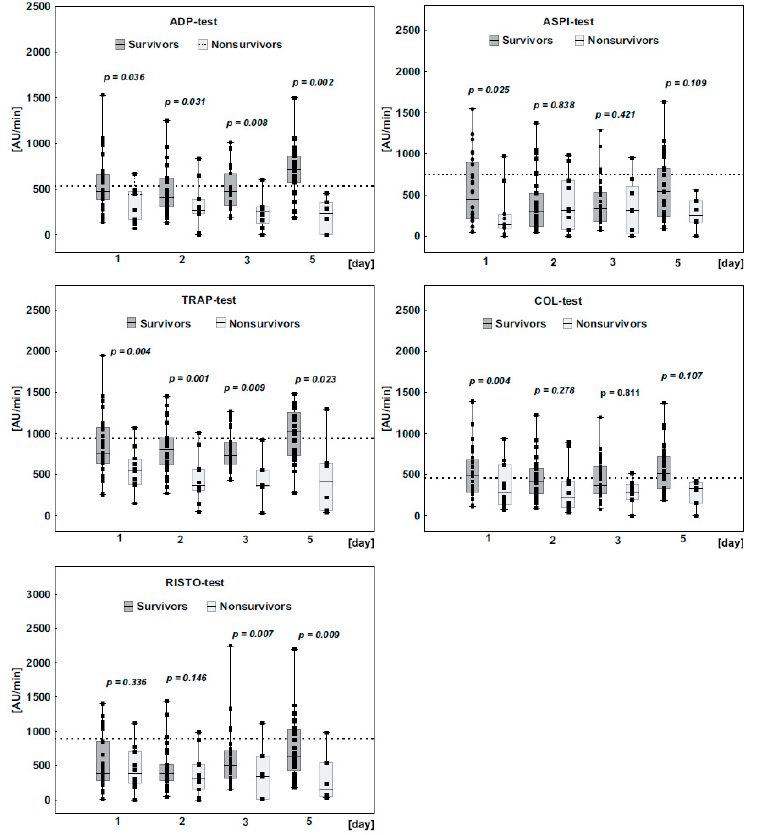
Figure 2. A comparison of the changes in platelet receptor activity between Survivors and Non- survivors in the following days of observation. A dotted line represents the lower reference range and the reference ranges for each test are as follows: ADP-test 534–1220 AU/min, TRAP-test 941–1536 AU/min, RISTO-test 896–2013 AU/min, ASPI-test 745–1361 AU/min, COL-test 459–1166 AU/min. The p -value represents statistically significant differences between the study groups. The box plots represent the median values (middle line) with upper and lower quartiles (box); the whiskers represent the minimum and maximum